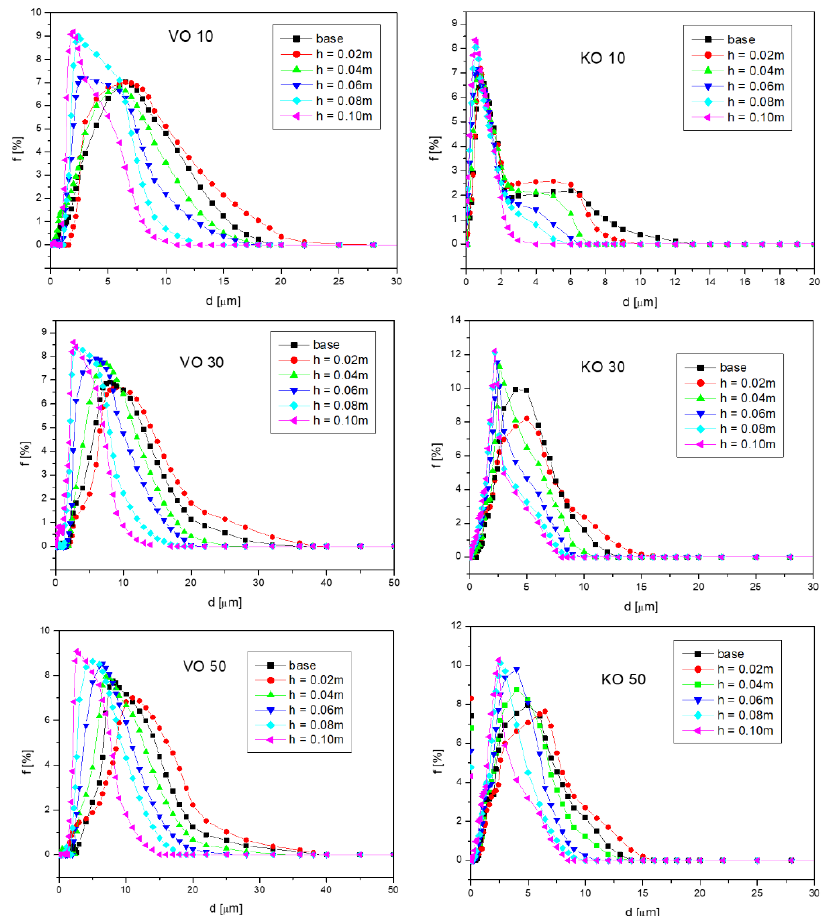
Figure 2. Diameter size distribution for emulsions obtained from liquid analyses for successive fragments of fibrous material, VO 10, VO 30, and VO 50—vegetable oil emulsions with initial concentrations of 10, 30, and 50%, respectively; KO 10, KO 30, and KO 50—kerosene emulsions with initial concentrations of 10, 30, and 50%